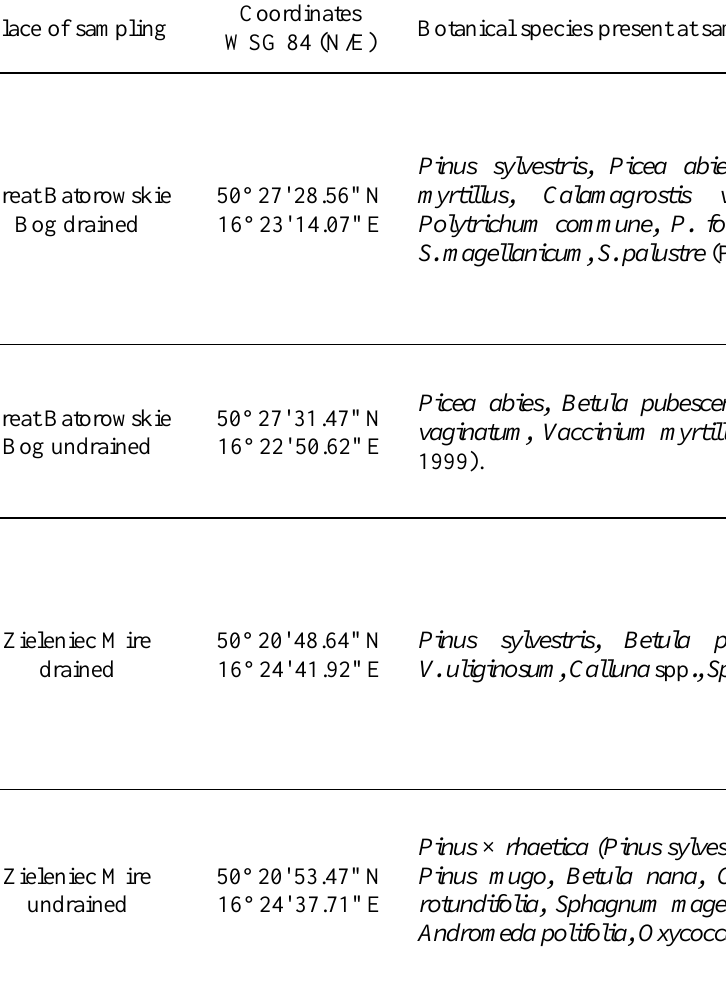
Table 1. Sampling locations for Great Batorowskie Bog and Zieleniec Mire (Poland), including botanical composition of vegetation cover and peat stratigraphy. Place of